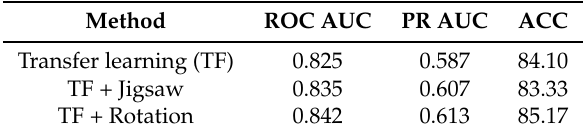
Table 5. Training on 2000 images (whole dataset) with data augmentation.